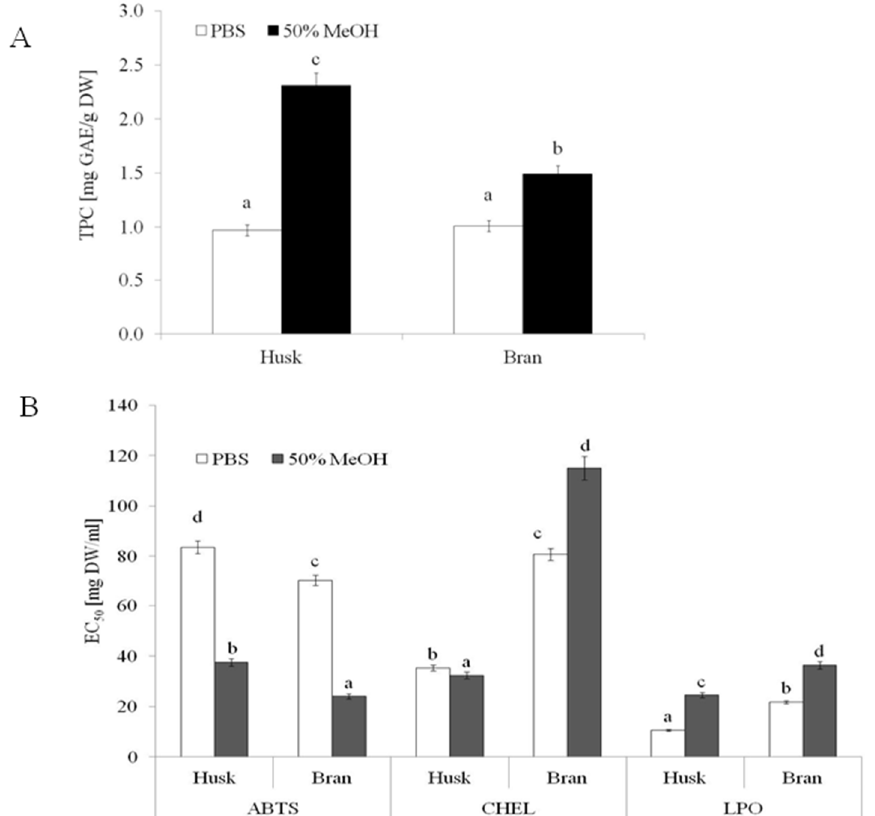
Figure 1. TPC ( A ) and AA ( B ) of micronized OB and OH. PBS—buffer extract; 50% MeOH— hydroalcoholic extract; ABTS—antiradical activity; CHEL—chelating power; LPO—ability to protect lipids against oxidation. Means followed by different lowercase letters (a–d) are significantly different at p < 0.05.